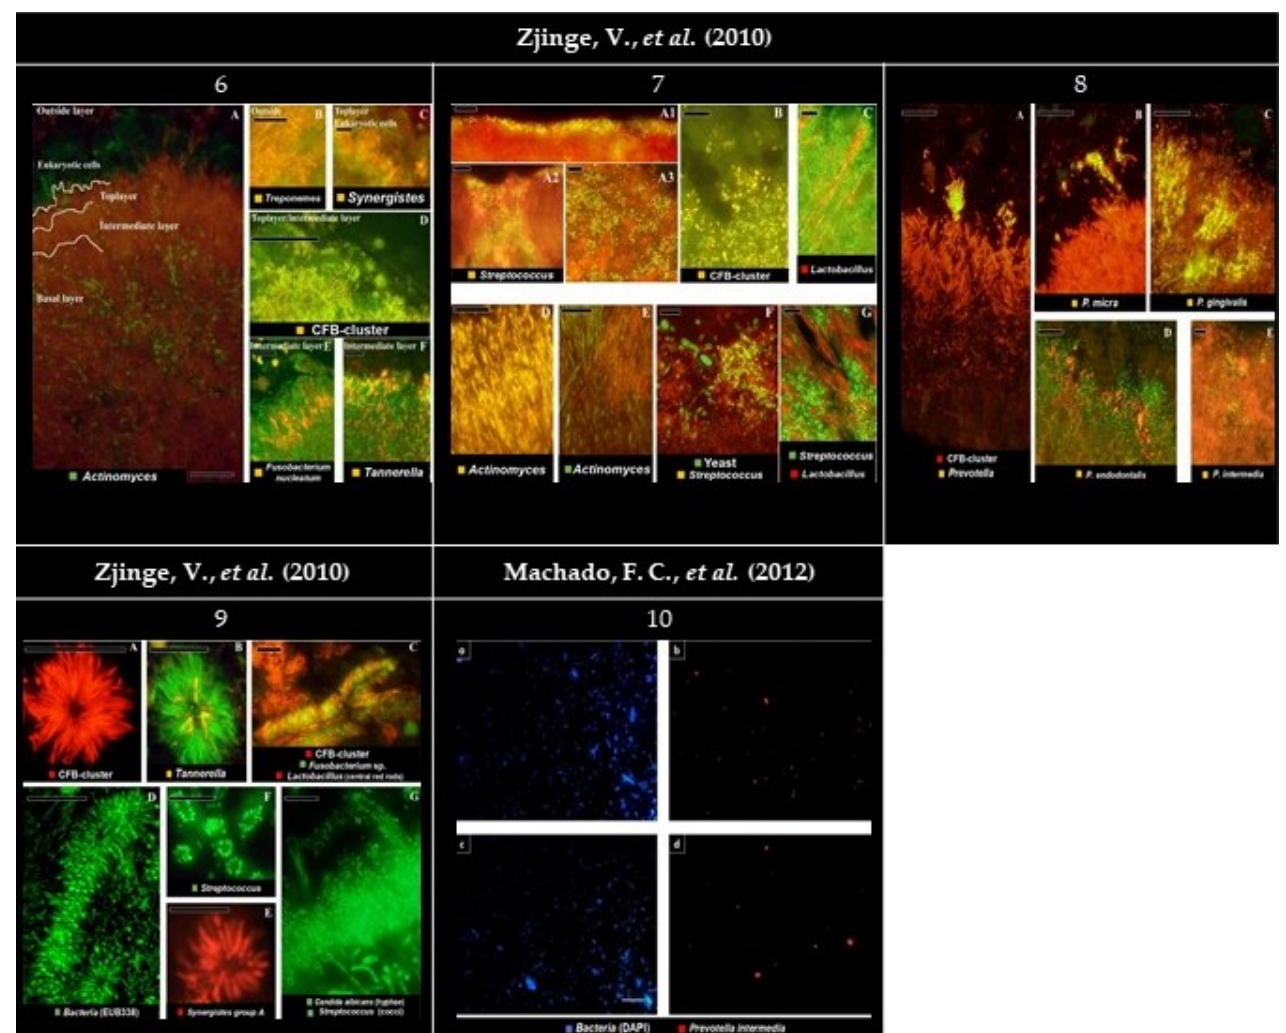
Figure 4. Panel of the gathered images. ( 6 ) Localization of the most abundant species in subgingival biofilms. ( 6A ) Overview of the four layers of subgingival biofilm. Actinomyces sp. (green), bacteria (red), and eukaryotic cells (large green cells on top). ( 6B ) Spirochaetes (yellow) outside the biofilm, without clear organization. ( 6C ) Detail of Synergistetes (yellow) in the top layer near PMN’s (Polymorphonuclear leukocytes) (green). ( 6D ) Presence of the Cytophaga-Flavobacterium-Bacteroides cluster (CFB-cluster) (yellow) in the top and intermediate layer. ( 6E ) Fusobacterium nucleatum in the intermediate layer. ( 6F ) Tannerella sp. (yellow) in the intermediate layer. Each panel is double-stained with probe EUB338 labeled with FITC (Fluorescein isothiocyanate) or Cy3 (Cyanine 3). Bars indicate 10 µm. ( 7 ) Localization of the most abundant species in supragingival biofilms. ( 7A1 – C ) The second layer. ( 7D – G ) Basal layer. ( 7A1 – 3 ) Streptococcus sp. disposed of in different ways on the second layer. ( 7B ) Cells from the CFB-cluster stained in the top layer of the biofilm. ( 7C ) Lactobacillus sp. (red) through the top layer. ( 7D ) On the basal layer, Actinomyces sp. cells (yellow). ( 7E ) Actinomyces sp. (green) and chains of cocci. ( 7F ) Colonies of Streptococcus sp. (yellow) all-around yeast cells (green) and bacteria unidentified (red). ( 7G ) Streptococcus sp. (green) growing closely to Lactobacillus sp. (red). Black holes might be channels through the biofilm. Panels ( A – C , E , F ) are double stained with probe EUB338 labeled with FITC or Cy3. Bars indicate 10 µm. ( 8 ) Localization of presumptive species associated with periodontitis in subgingival biofilms. ( 8A ) Colonization of the subgingival biofilm by the CFB-cluster species (red) and Prevotella sp. (yellow). Since Prevotella sp. are part of the CFB-cluster of bacteria, cells appear in yellow. ( 8B ) Top of the biofilm with a micro-colony of Parvimonas micra (yellow). ( 8C , D ) Micro-colonies of Porphyromonas gingivalis (yellow) and Porphyromonas endodontalis (yellow) in the top layer, respectively. ( 8E ) Micro-colonies of Prevotella intermedia in the top layer. Panels B, C, D, and E are double stained with probe EUB338 labeled with FITC or Cy3. Bars indicate 10 µm. ( 9 ) Bacterial aggregates detected in both sub- and supragingival plaque. ( 9A ) Filamentous cells from the CFB-cluster in the fourth layer of the subgingival plaque. ( 9B ) Tannerella sp. (yellow) in a test-tube brush. ( 9C ) Test-tube brush with Lactobacillus sp. (red rods) as central structures. Fusobacterium nucleatum (green) and CFB-cluster filaments (red), morphologically identical to Tannerella forsythia, perpendicularly radiating around lactobacilli. ( 9D ) Test tube brush stained with the eubacterial probe. ( 9E ) Synergistetes group A species forming aggregates